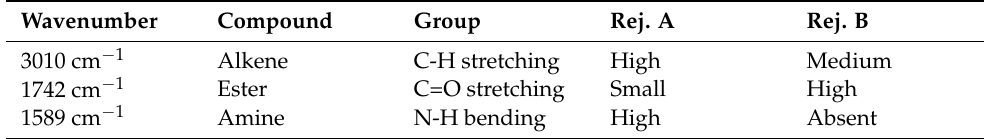
Table 4. Characteristic peaks of the rejuvenators from FTIR analysis.